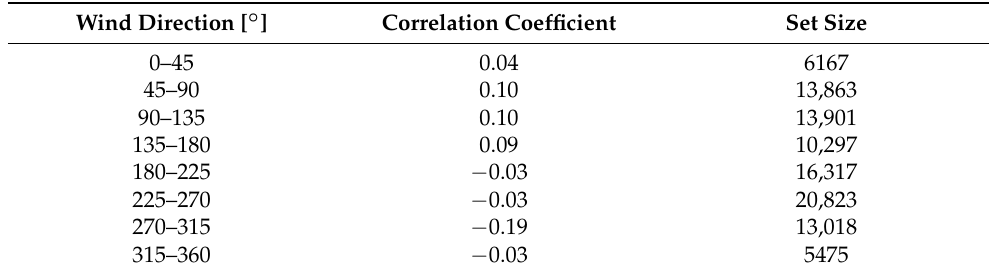
Table 1. Pearson correlation coefficient, wind direction/FW3 power.